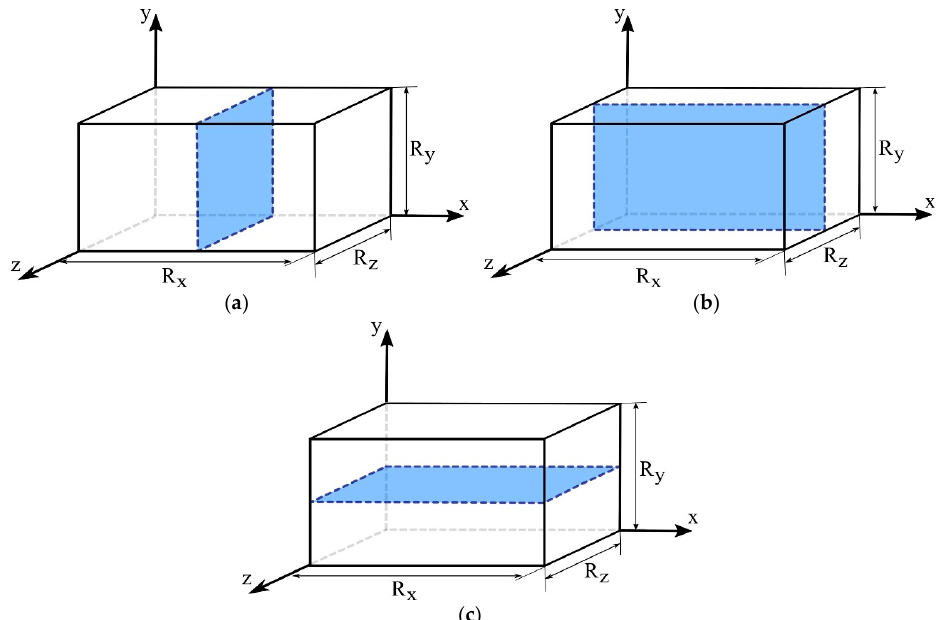
Figure 11. Cartesian plans used for analyzing the free and entrapped solute concentration inside the composite. ( a ) x = R x /2; ( b ) y = R y /2, and ( c ) z = R z /2.